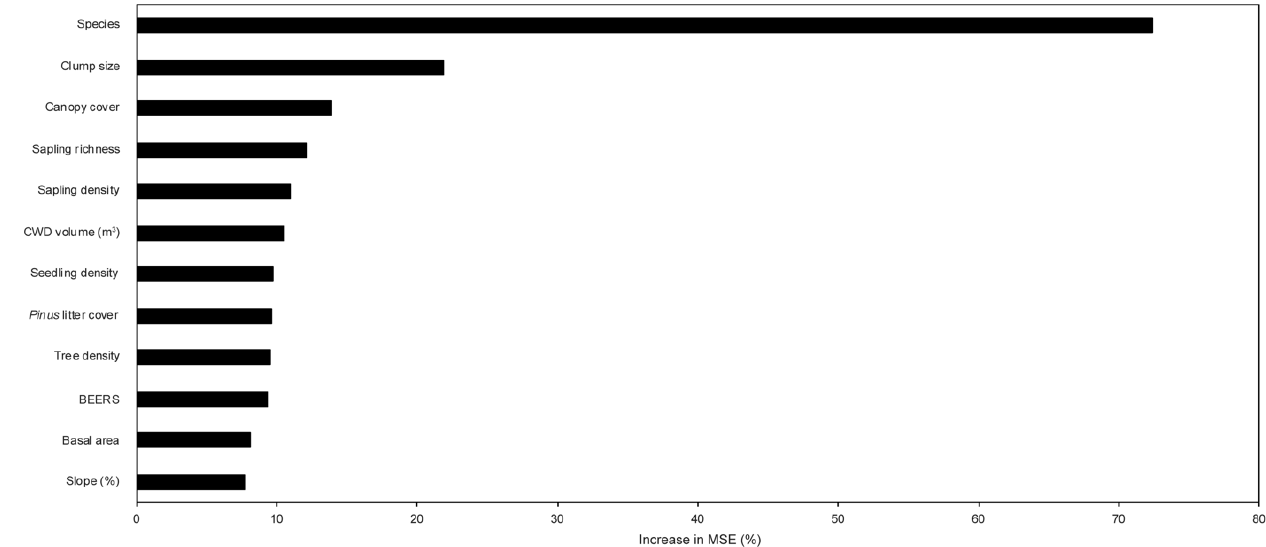
Figure 3. Importance ranking for the influence of species and biophysical site conditions on sapling height. CWD is coarse woody debris. BEERS is transformed aspect. The percent increase in mean square error (MSE) is the increase in model error when the predictor variable was randomly permuted.